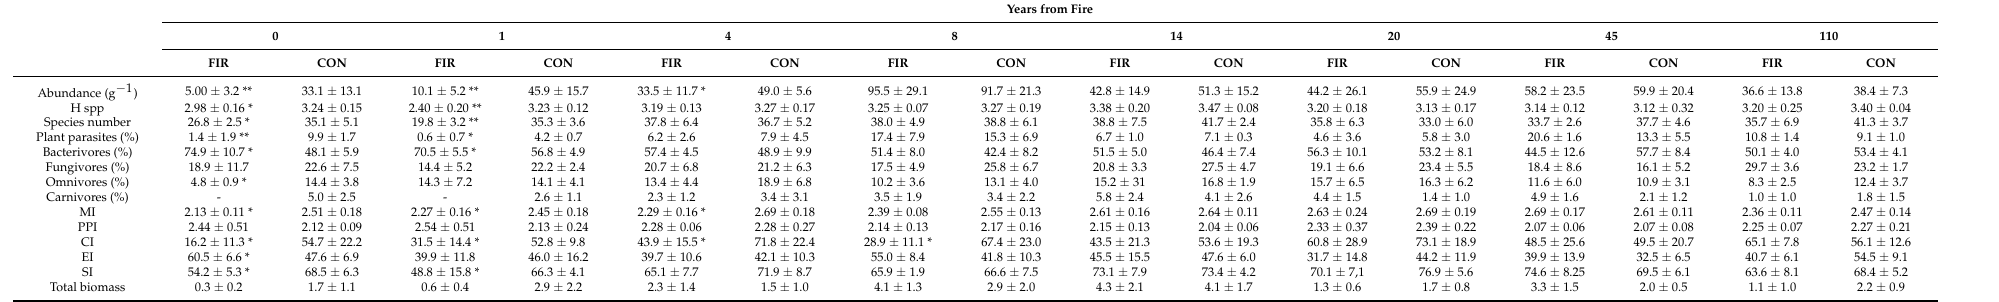
Table 3. Mean value ( ± S.D, n = 6) of nematode community indices taken from forest plots affected by high severe fires.